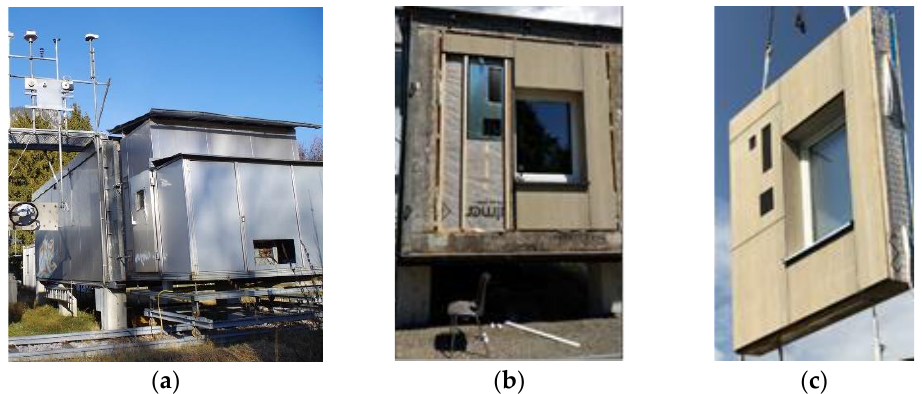
Figure 22. PASSYS test cell ( a ) and functional model of a prefabricated wooden façade element with integrated outdoor unit of the heating-ventilation heat pump in the PASSYS test cell of the UIBK. ( b ) Installation of the façade element. ( c ) Execution (Holzbau Kulmer, Pischelsdorf am Kulm, Styria, Austria).